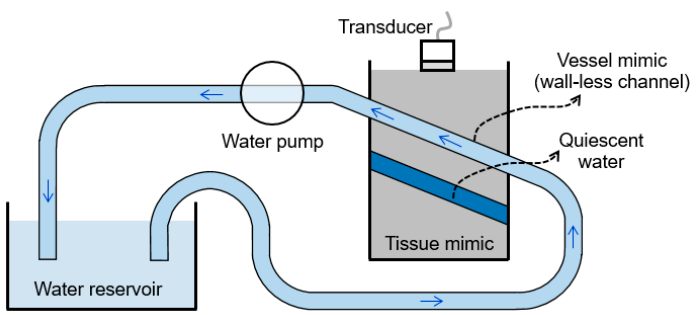
Figure 16. Flow phantom